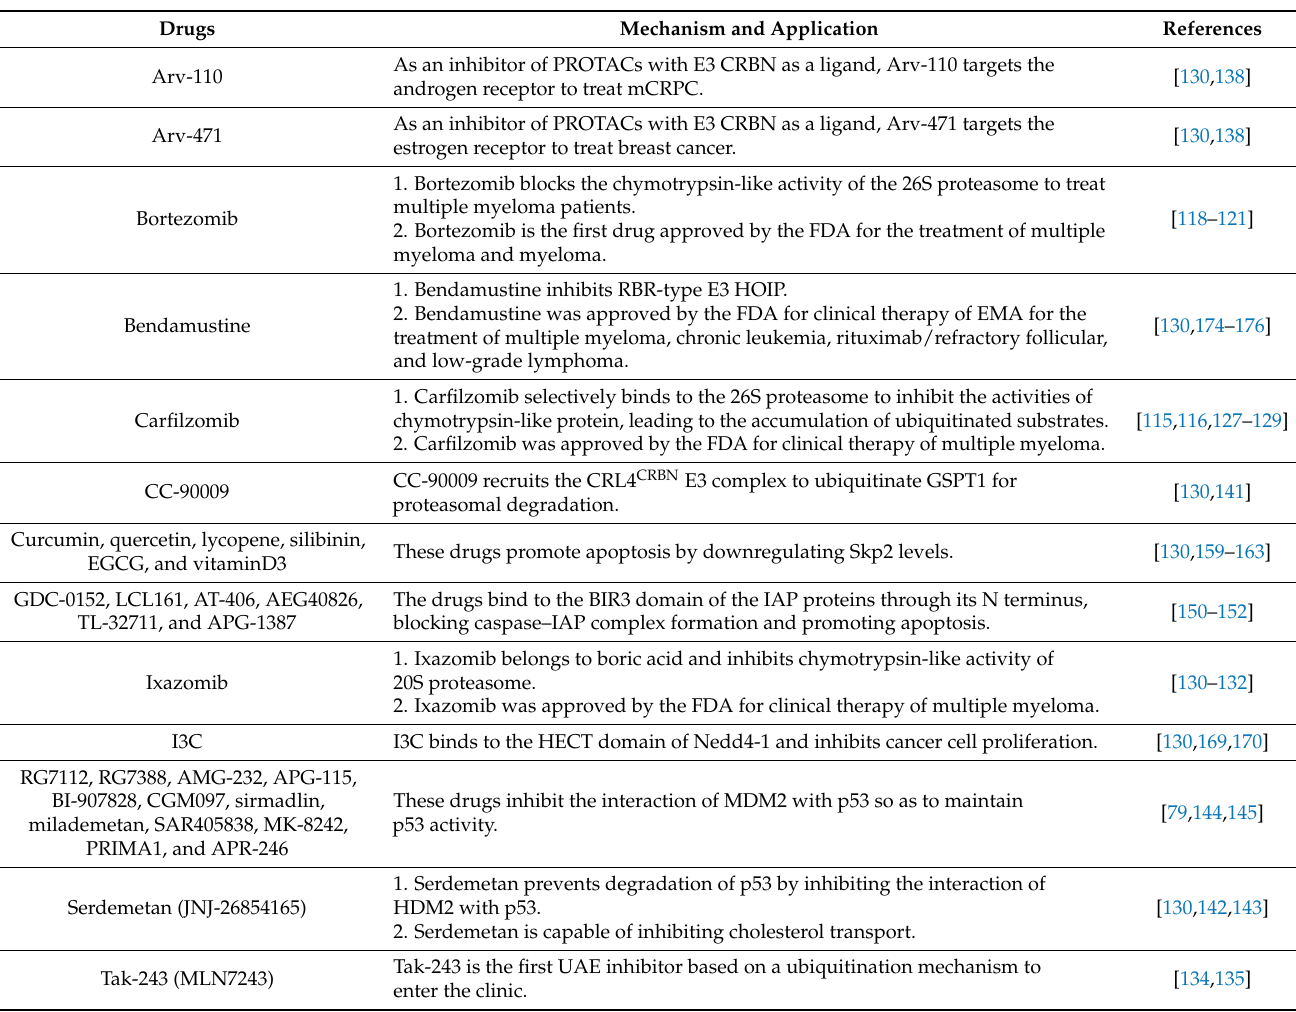
Table 2. Drugs targeting ubiquitination factors approved or in clinical